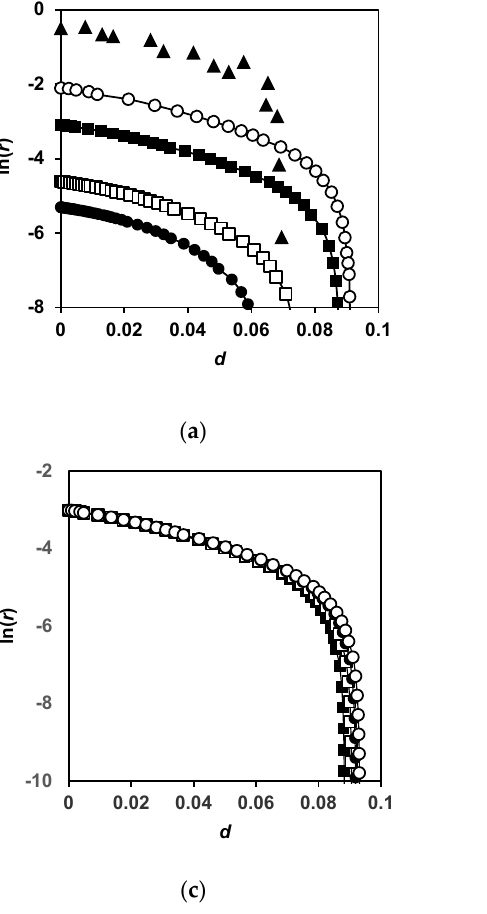
); ( b ) illustration (cid:35)